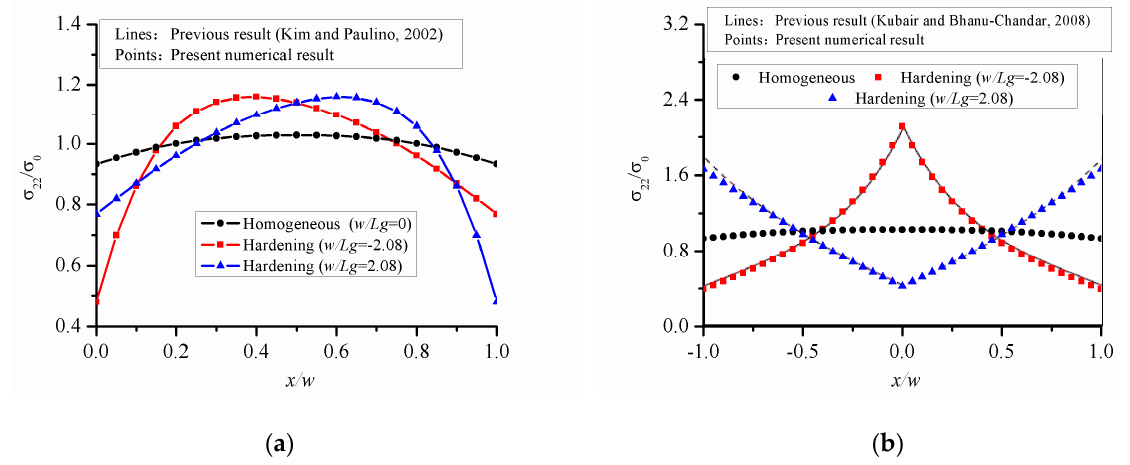
Figure 3. Variation of the normal stress in a uniform FGM panel without hole under tension load along the y-direction. ( a ) x-FGM changes monotonously along x-direction; ( b ) x-FGM symmetrical about x = 0.